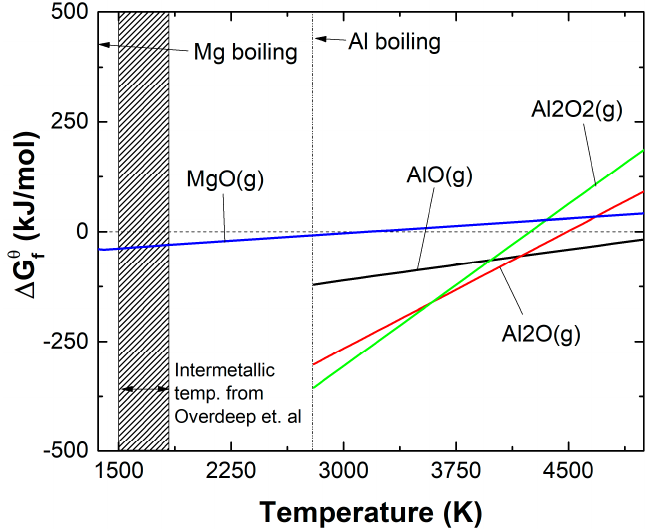
Figure 9. Gibbs free energy of formation curves for possible vapor products plotted from the boiling point of the respective element and beyond. Figure reproduced from the National Institute of Standards and Technology (NIST) JANAF tables [66].